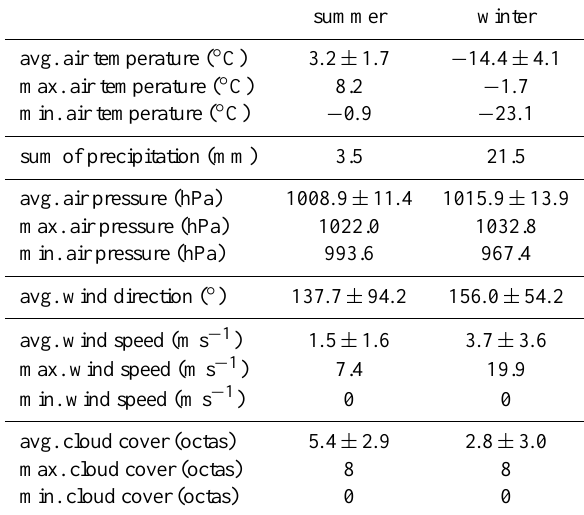
Table 1. Meteorological average conditions, ± standard deviations and minimum and maximum conditions during the water sampling period in summer (24 August to 7 September 2009) and winter (15 February to 7 March 2010). The values were measured in Ny- ˚Alesund and provided by the Norwegian Meteorological